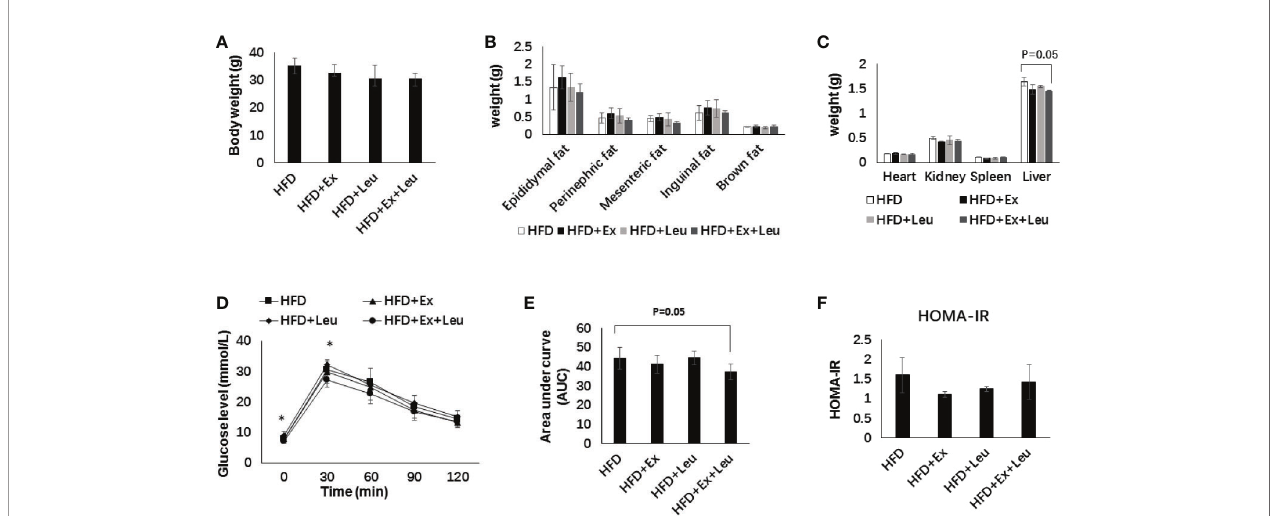
FIGURE 2 | The intervention of exercise and leucine improve insulin sensitivity under HFD. C57BL/6J male mice of 5 – 6 weeks were fed with HFD. Leucine with a concentration of 1.5% and/or moderate intensity exercise was added in the 10th week and administrated for 4 weeks. (A) Changes in body weight. (B) Changes in fat content. (C) Changes in organ weight. (D) Glucose tolerance test. Mice were fasting overnight; D-glucose (2 g/kg) was injected intraperitoneally. Blood glucose concentration was detected 0 min before injection and 30, 60, 90, and 120 min after injection. (E) Area under curve of GTT. (F) HOMA-IR. Calculated based on fasting glucose level (mmol/L) and fasting insulin level ( m U/ml). The data are mean ± s.d. (error bars), n = 6 mice per group. *p < 0.05 HFD versus HFD + Ex +